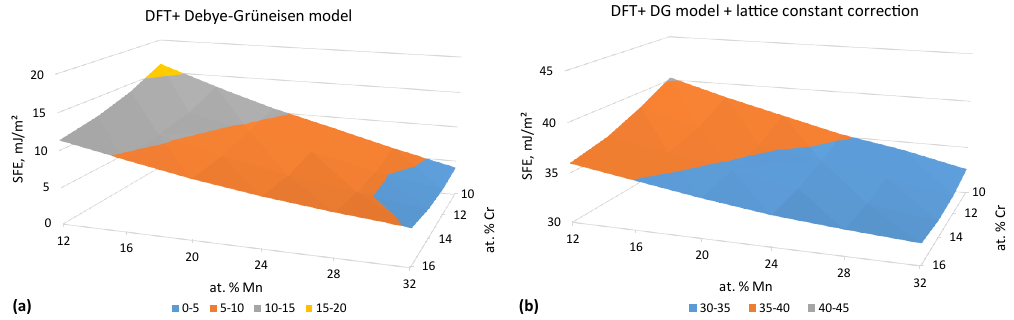
Figure 5. Intrinsic stacking fault energy of the PM FeCrMn alloys at 300 K. ( a ) DFT and Debye-Grüneisen model calculations. ( b ) DFT and Debye-Grüneisen model calculations corrected to the absolute lattice constant value difference between theoretical results and the experiment [66].